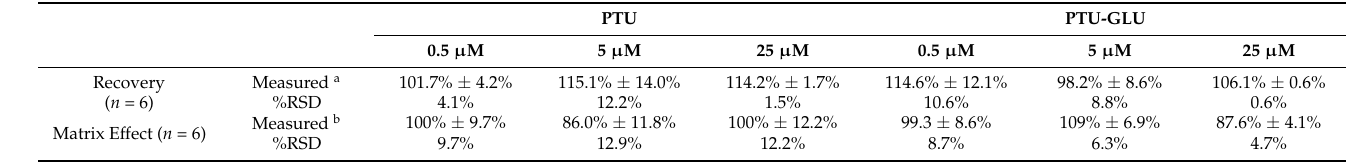
Table 3. Recovery and matrix effect of PTU and PTU-GLU from human liver microsomes.